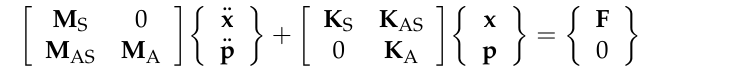
Table 1. Material parameters of the finite element model. Material Parameters Material Types